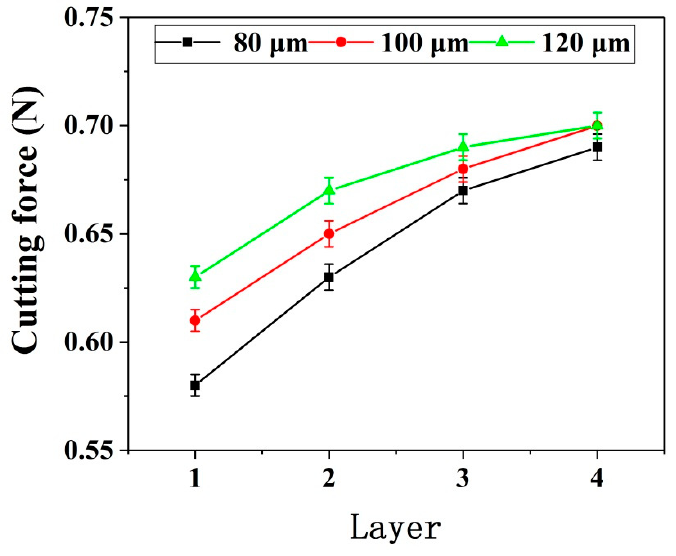
Figure 9. Thin wall cutting force.